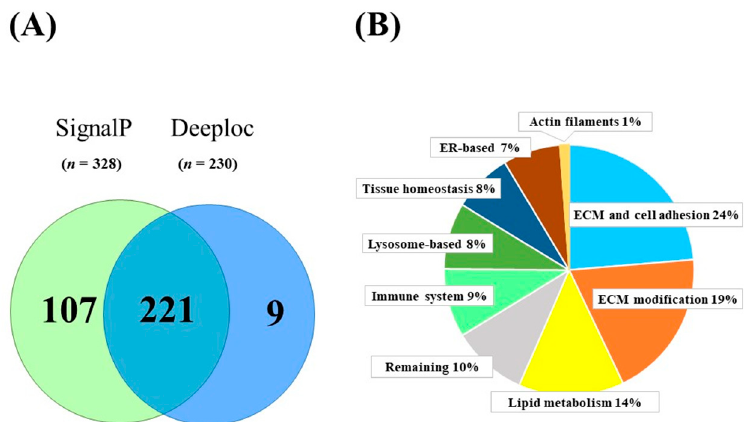
Figure 1. Secreted proteins identified in human Simpson Golabi Behmel Syndrome (SGBS) adipocytes. ( A ) The number of identified secreted proteins by SignalP or Deeploc. ( B ) Pie graph on functional categories of overall identified secreted proteins.